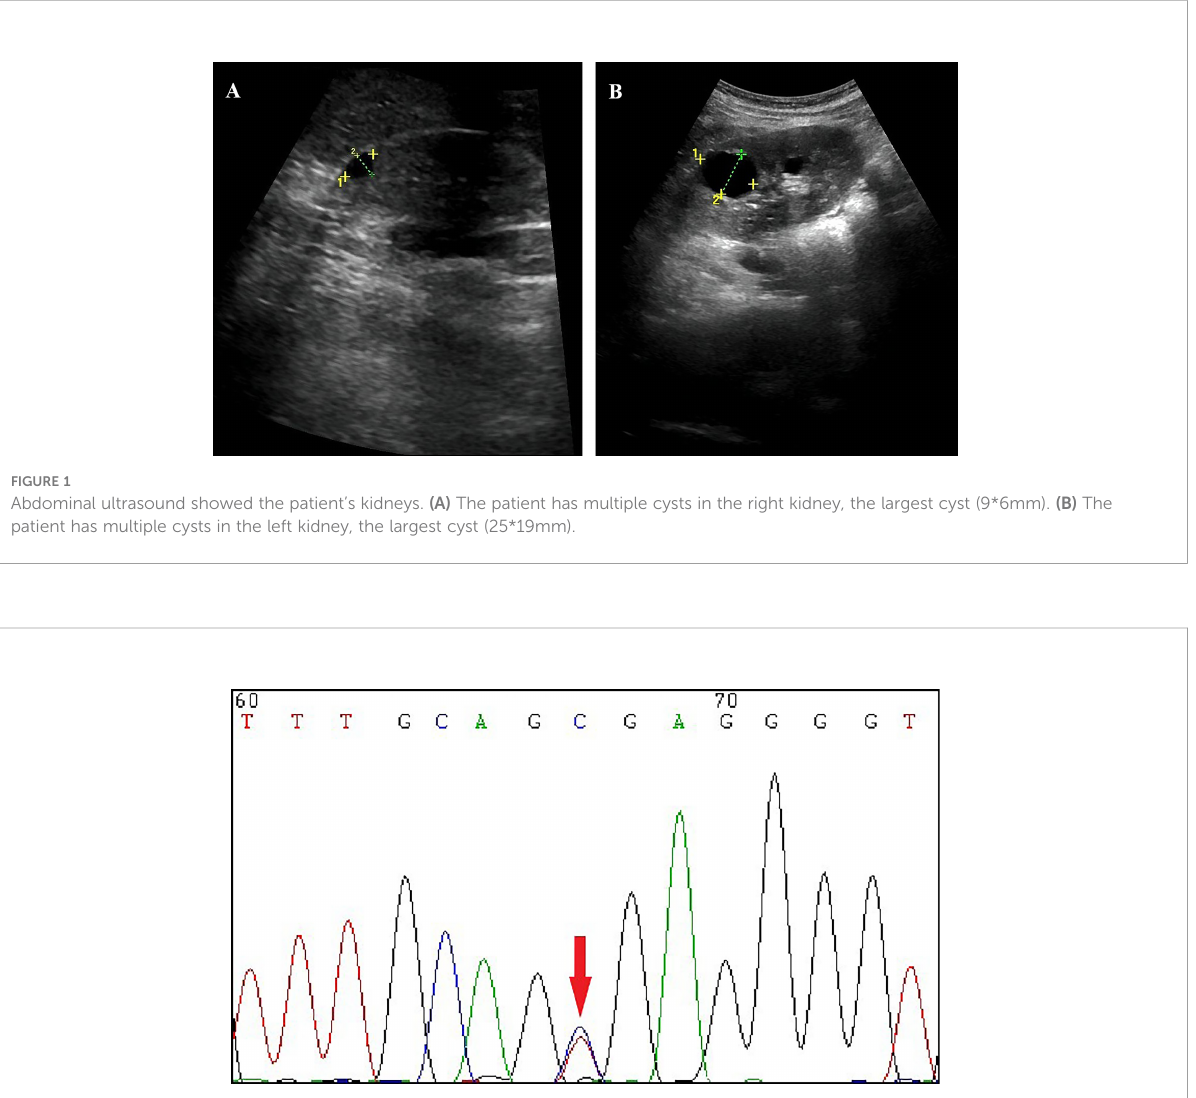
FIGURE 2 The Sanger sequencing showed a heterozygous mutation of HNF1B gene in exon 4 (c.826C>T, p.Arg276*) of the